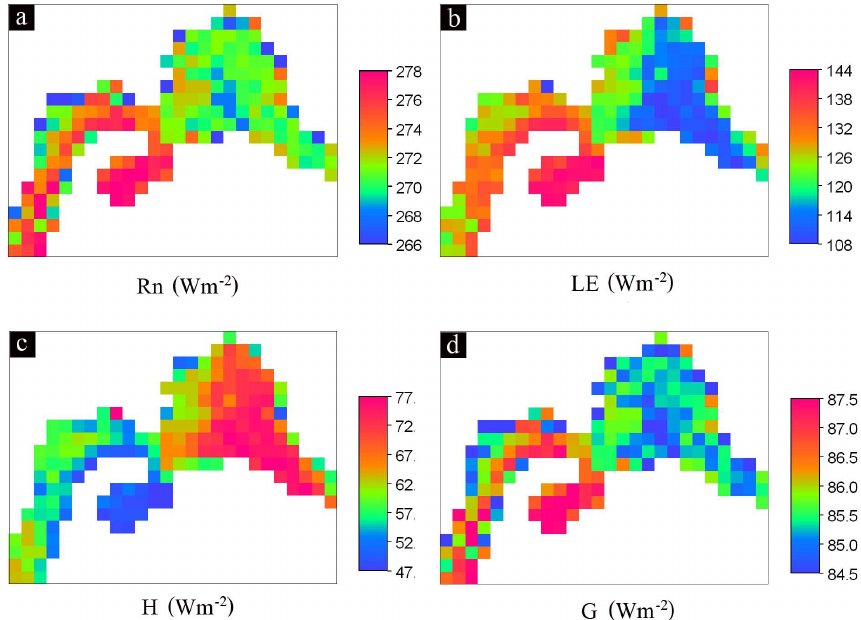
Fig. 9. The SEBS calculated maps of the instantaneous components of the surface energy balance, i.e. (a) net radiation; (b) latent heat flux; (c) sensible heat flux; (d) ground heat flux, on 17 January 2007,